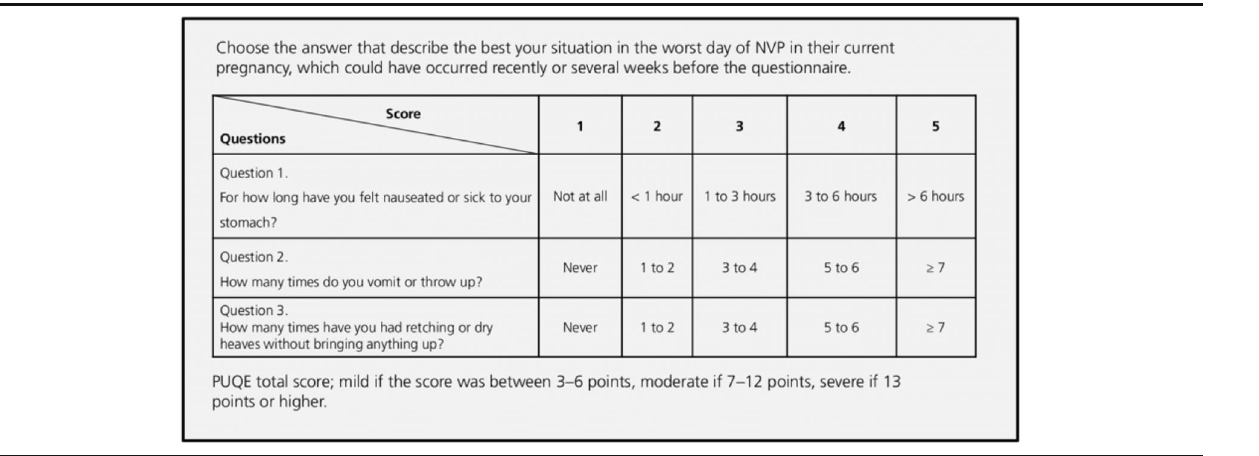
Table 1 PUQE Score (from Koren et al.,